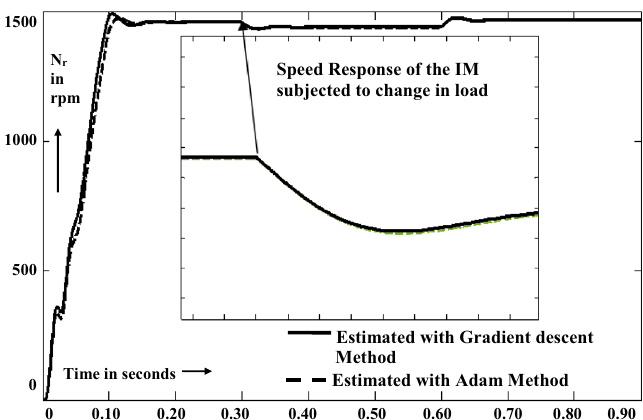
Fig. 9 Speed Response of IFOC VSI-IM drive with a sudden change in